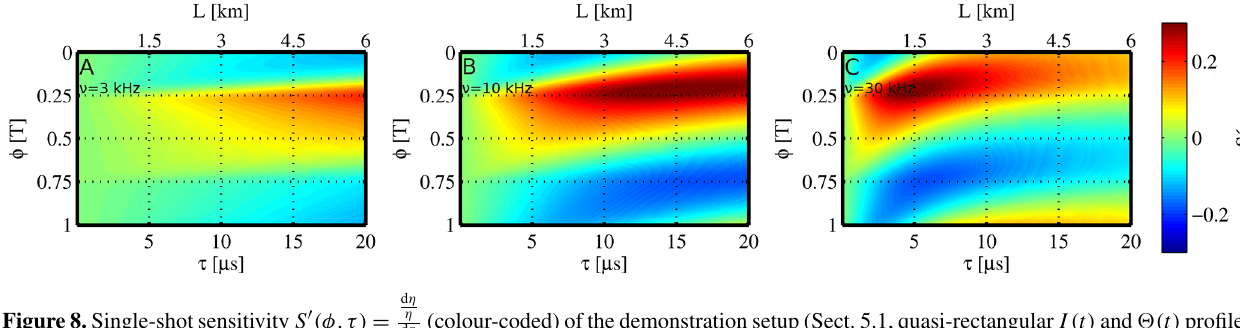
Figure 8. Single-shot sensitivity S (cid:48) (φ,τ) = for three different modulation frequencies ν . Fields of high | S (cid:48) | indicate where ICOM is sensitive to retrieving L .